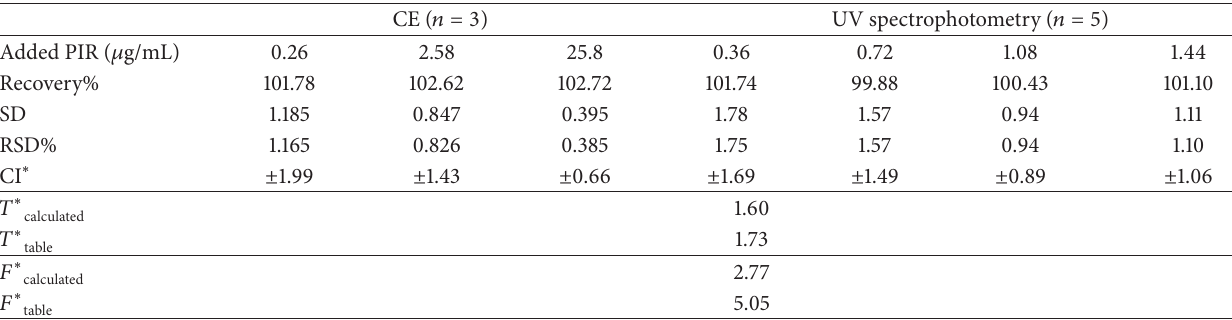
Table 4: Application and comparison of the